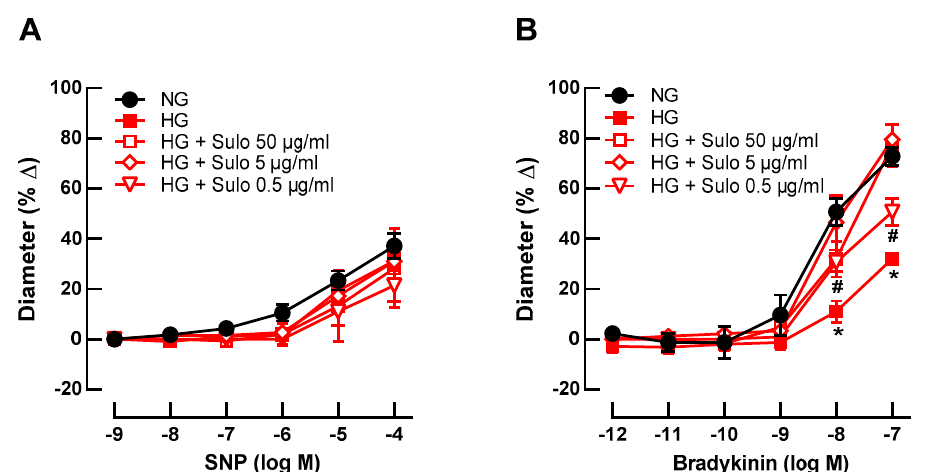
Figure 2. Concentration-dependence studies for sulodexide. Vascular reactivity of retinal arterioles to the endothelium-independent vasodilator SNP (A) and to the endothelium-dependent vasodila- tor bradykinin (B) after incubation with highly concentrated glucose solution (HG) and different sulodexide concentrations for two hours: 50 µg/mL, 5 µg/mL, and 0.5 µg/mL. Vessels incubated with normally concentrated glucose solution (NG) served as controls. Data are expressed as mean ± SE ( n = 8 per concentration and group; * p < 0.05, HG versus all other groups; # p < 0.05, HG + Sulo 0.5 µg/mL versus NG).